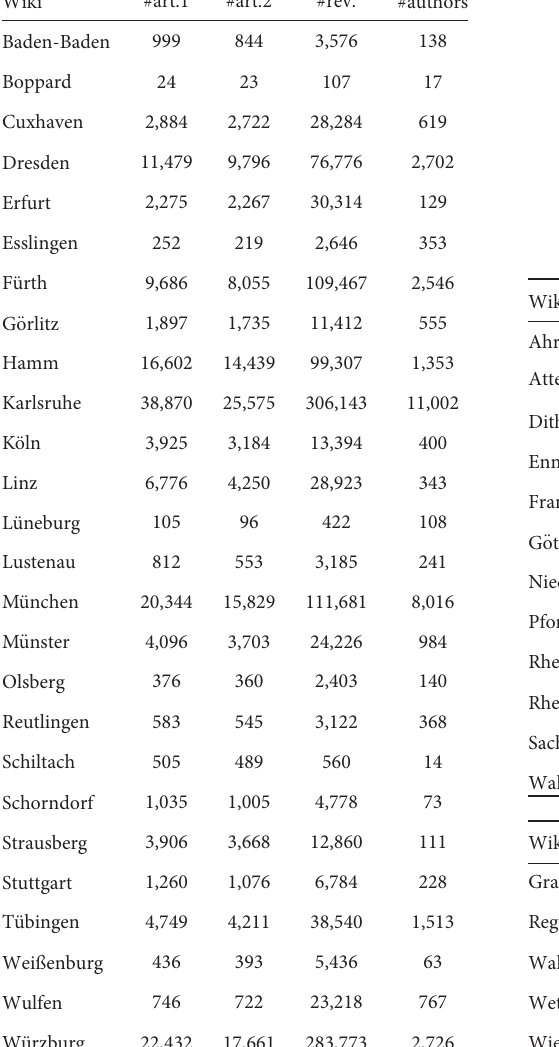
Table 1: Statistics of the FRWC showing the number of articles with (#art.1) and without (#art. 2) redirects, the number of revisions (#rev.), and the number of distinct authors